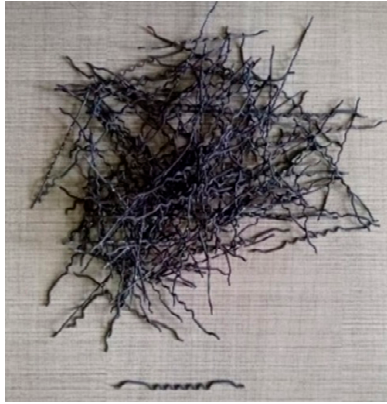
Figure 6. Geometric shape of steel fibers.